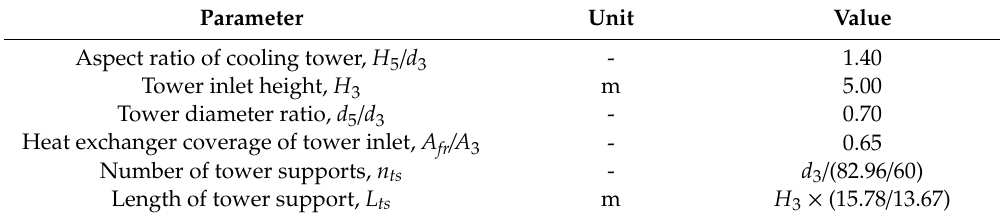
Table 3. Specified parameters for the design of the NDDCT.